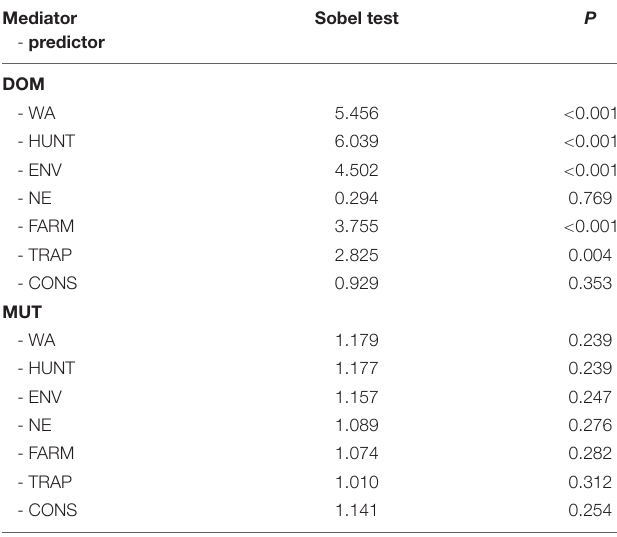
TABLE 6 | Sobel test